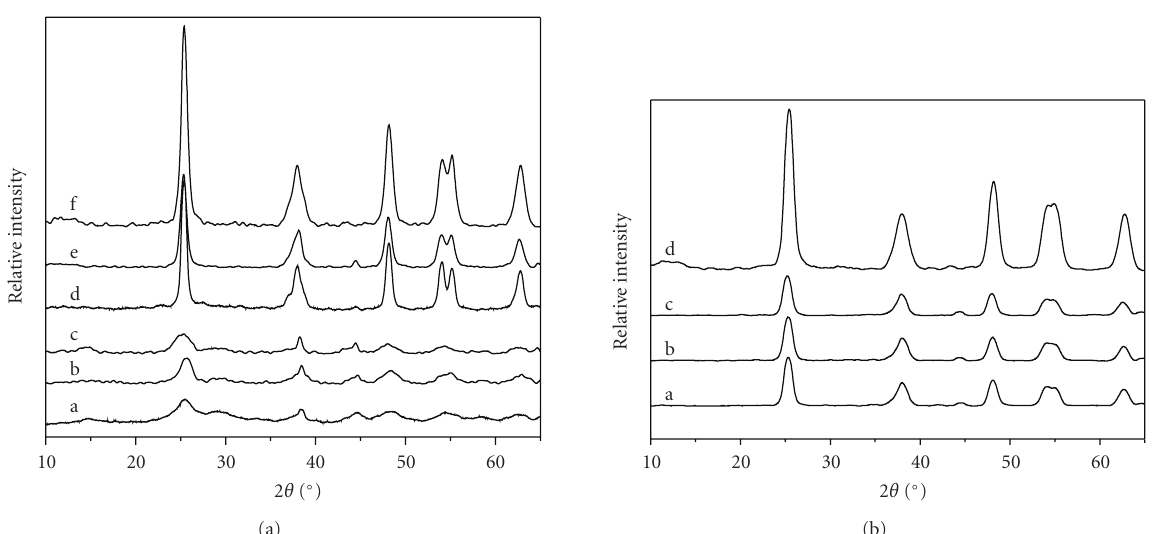
Figure 3: (a) Wide-angle powder XRD patterns of mesoporous TiO 2 and hydrothermally synthesized Au/TiO 2 samples: (a) H1, (b) H2, (c) H3, (d) H4, (e) H5, and (f) T1. (b) Comparative wide-angle powder XRD patterns of impregnation-prepared Au/TiO 2 and gold-free TiO 2 samples: (a) I1, (b) I2, (c) I3, and (d) T1.